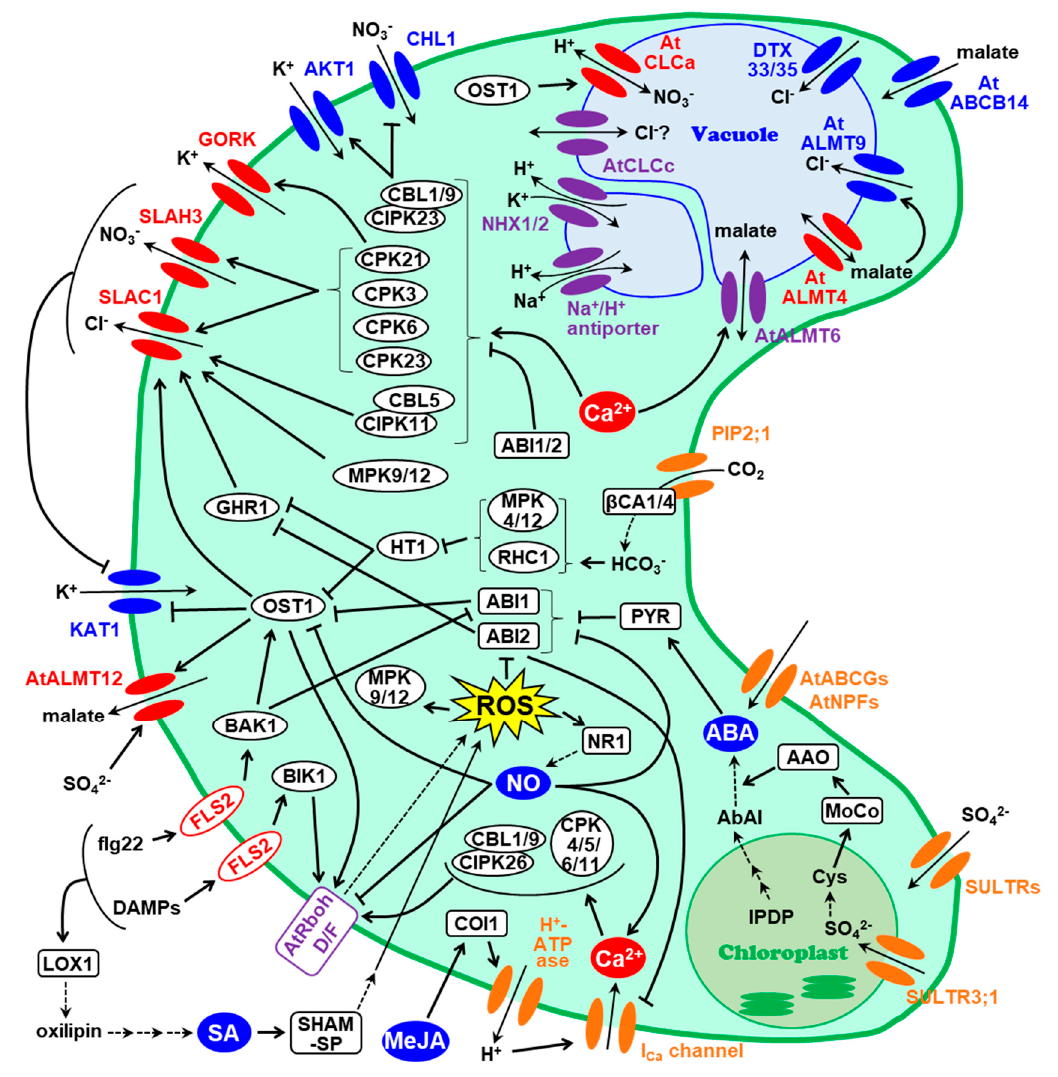
Figure 1. Schematic model of ion channel regulation during stress induced stomatal movement in Arabidopsis thaliana . Thin arrow, influx/efflux of compounds; thick arrow, activation or inhibition; broken arrow, breakdown or biosynthesis. Channels/Transporters, which have been evidenced to control stomatal opening or closure, are shown in red and blue, respectively. Channels shown in purple are the ones that contribute to both opening and closure, or their role in stomatal regulation still remains ambiguous. Other channels/transporters are shown in orange. Abbreviations; SHAM-SP, SHAM-sensitive peroxidase; IPDP, isopentenyl diphosphate; AbAl, abscisic aldehyde; MoCo, molybdenum cofactor; AAO, abscisic aldehyde oxidase.